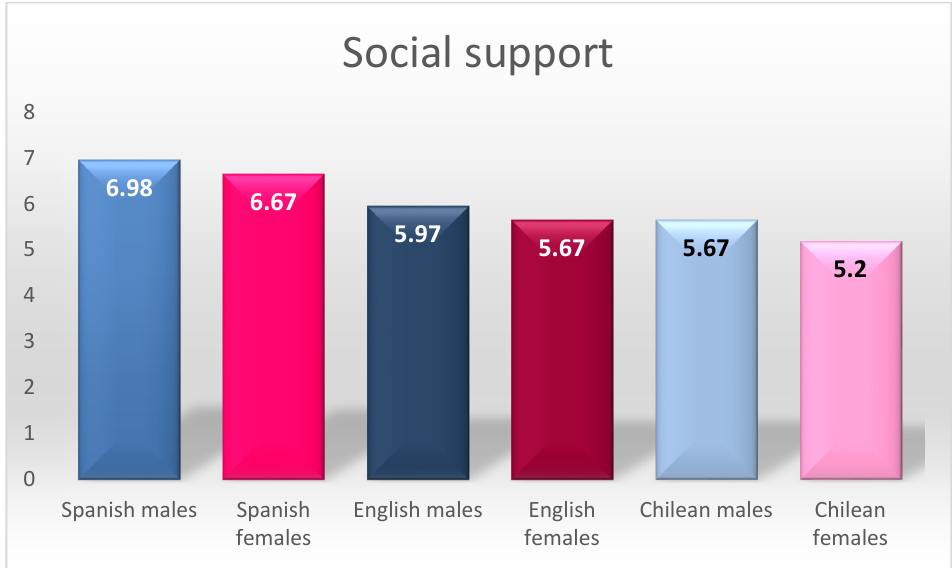
Figure 3. Summary of differences in social support.